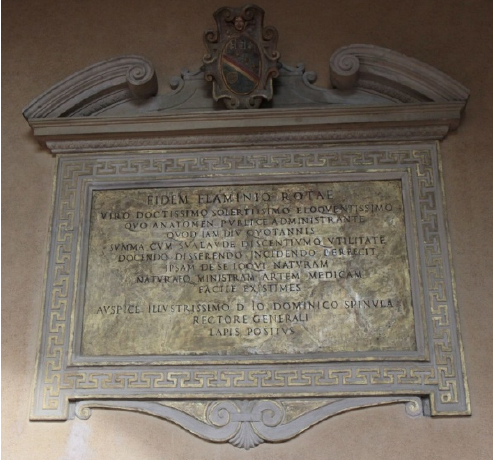
Figure 2. Flaminio Rota’s memorial tablet in the east side of the upper loggia of the Archiginnasio Palace in Bologna (1590). Source: http://himetop.wikidot.com/ (accessed on 25 June